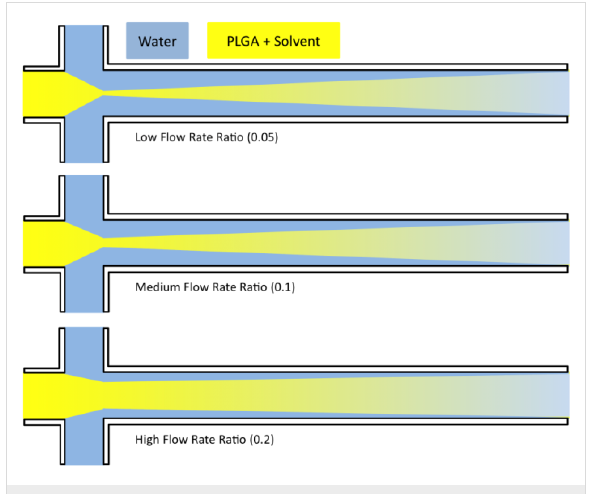
Figure 2: Illustration the impact of increasing the flow rate ratio on the mixing pattern and the geometry of the flowing solvents. The increas- ing mixing time at higher ratios could lead to larger particle sizes.